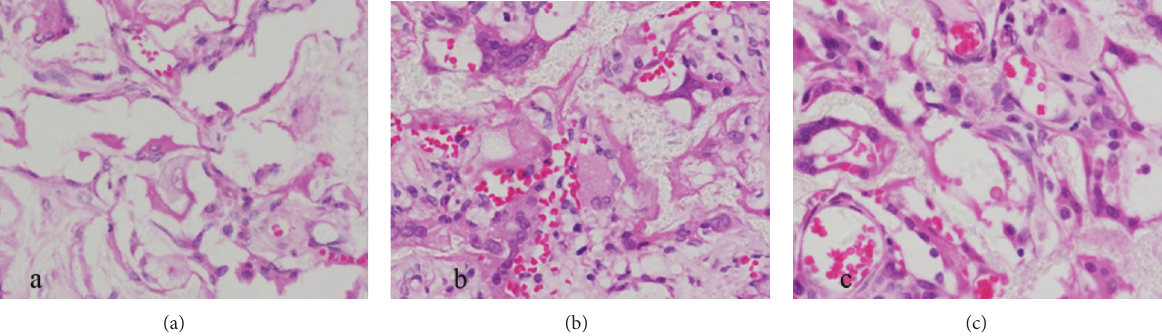
Figure 3: Hematoxylin and eosin (H & E) staining of specimens (magnification × 400): (a) 2 weeks, (b) 6 weeks, and (c) 10 weeks.